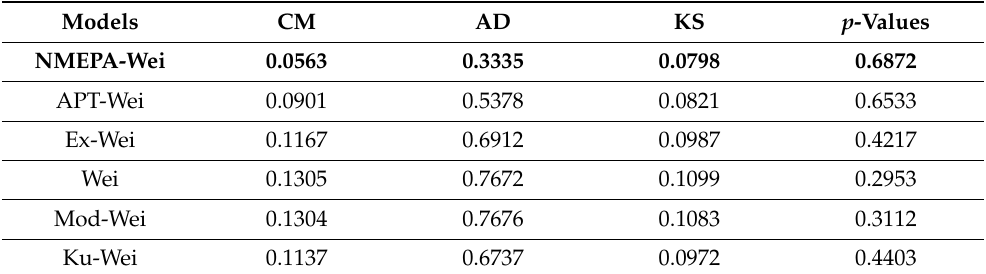
Table 7. The values of CM, AD, and KS measures and p -value of the competitive models for fatigue fracture data set (Data 2).